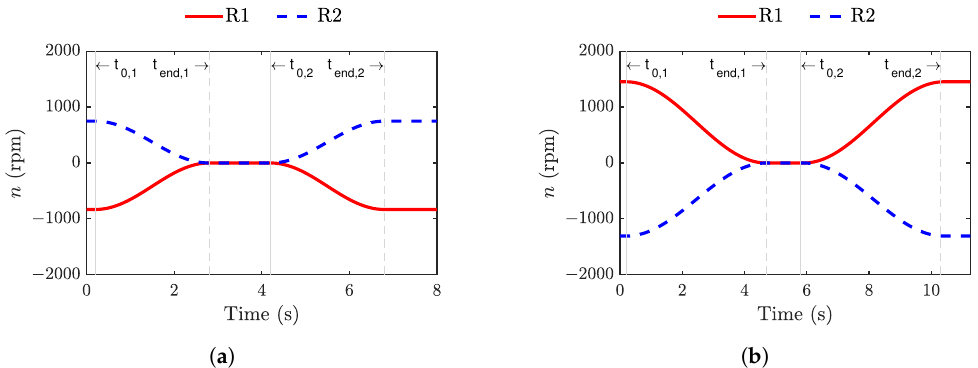
Figure 2. Rotational speeds of the runners as a function of time during the transient sequences. Here, R1 and R2 denote Runner 1 and Runner 2, respectively, t 0, i and t end, i correspond to the start respective end time of the transient operation. Index i is 1 for shutdown and 2 for startup. ( a ) Turbine mode: t 0,1 = 0.2 s, t end,1 = 2.8 s, t 0,2 = 4.2 s, t end,2 = 6.8 s. ( b ) Pump mode: t 0,1 = 0.2 s, t end,1 = 4.7 s, t 0,2 = 5.8 s, t end,2 = 10.3